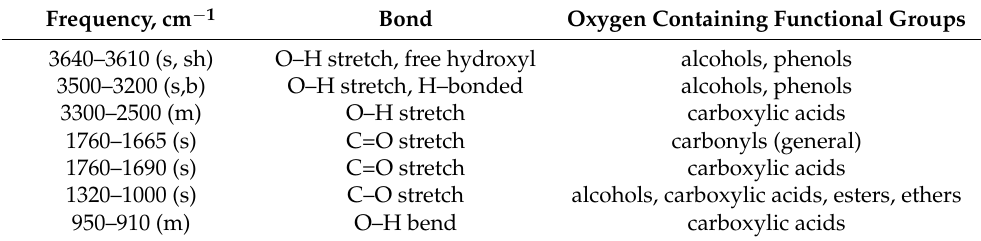
Table 2. Infrared spectra